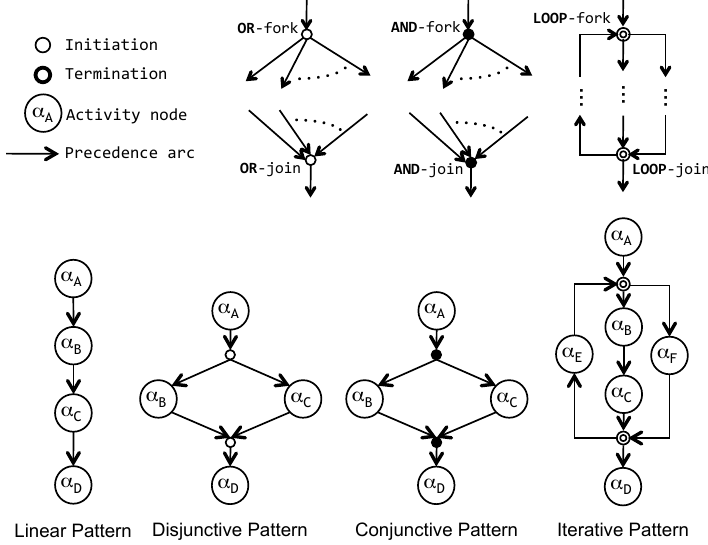
Figure 3. The structural control-flow primitives in structured information control net process